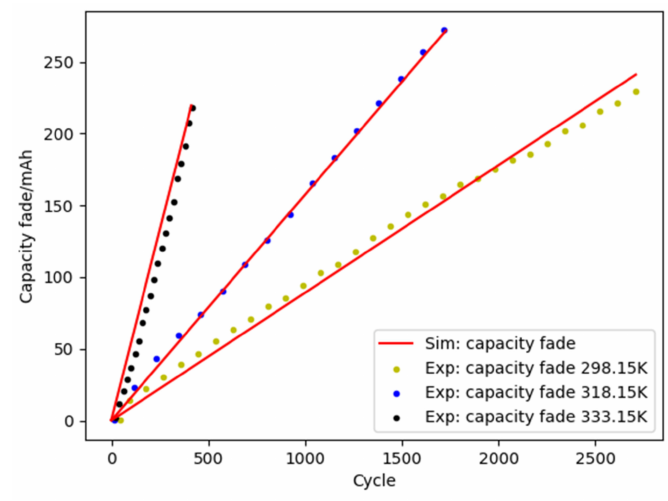
Figure 6. Comparison of fitting and experimental results.